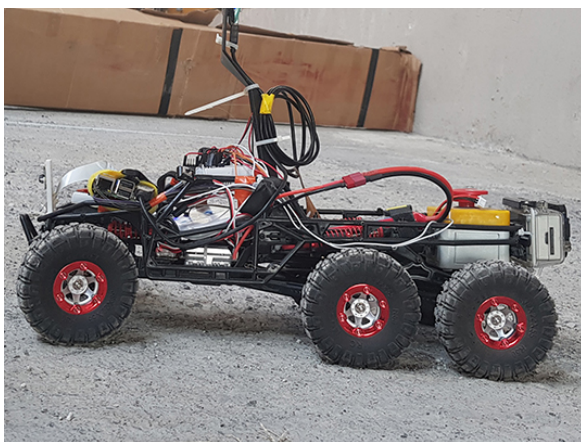
Figure 6. Our surface vehicle: Kraken.